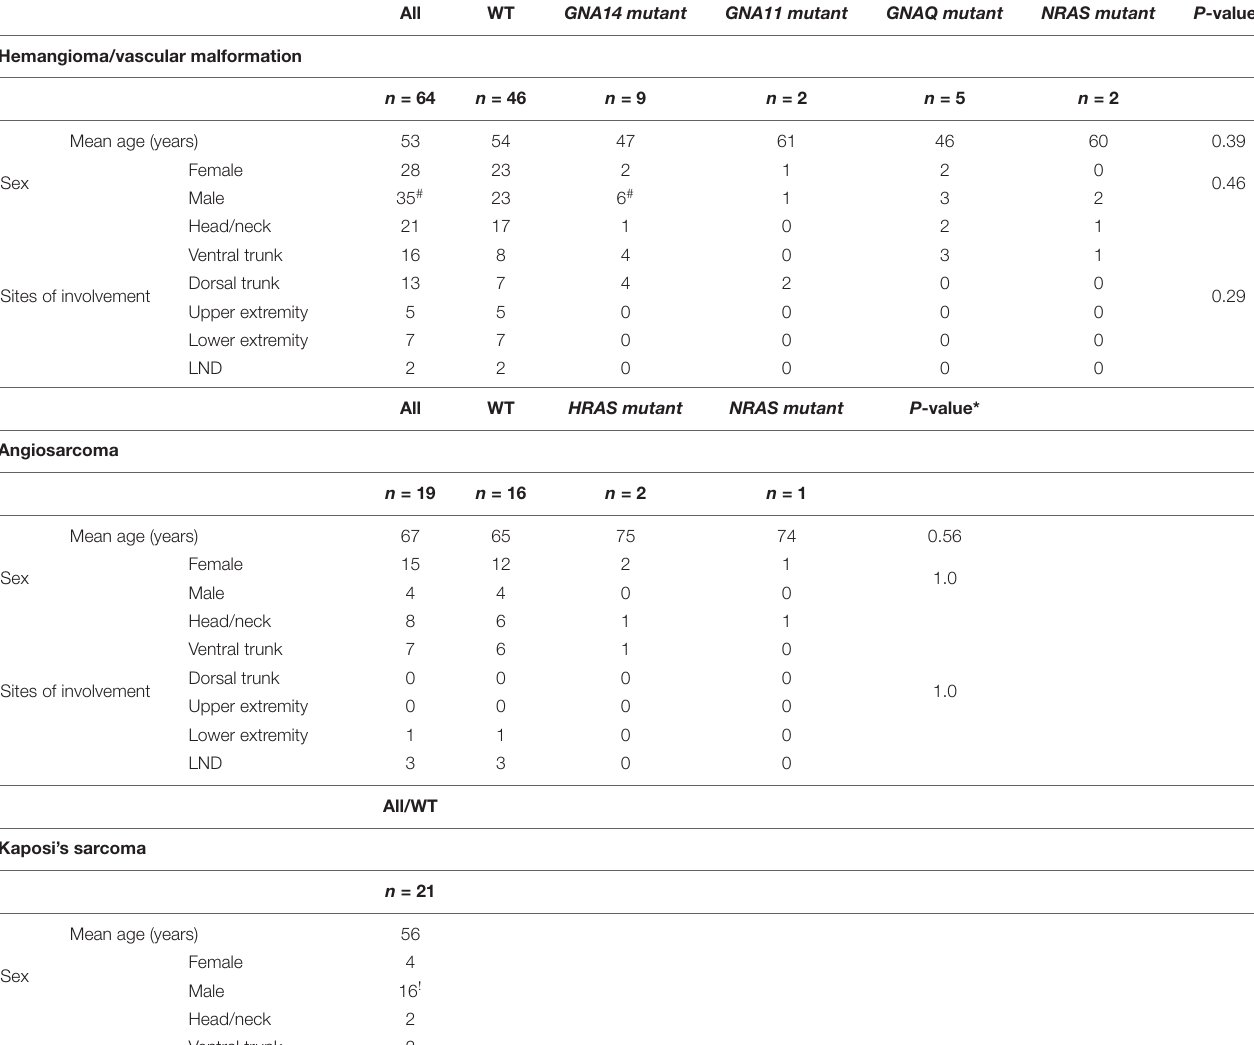
TABLE 1 | Associations of mutations with clinical variables for different vascular tumors and malformations. All WT GNA14 mutant GNA11 mutant GNAQ mutant NRAS mutant P